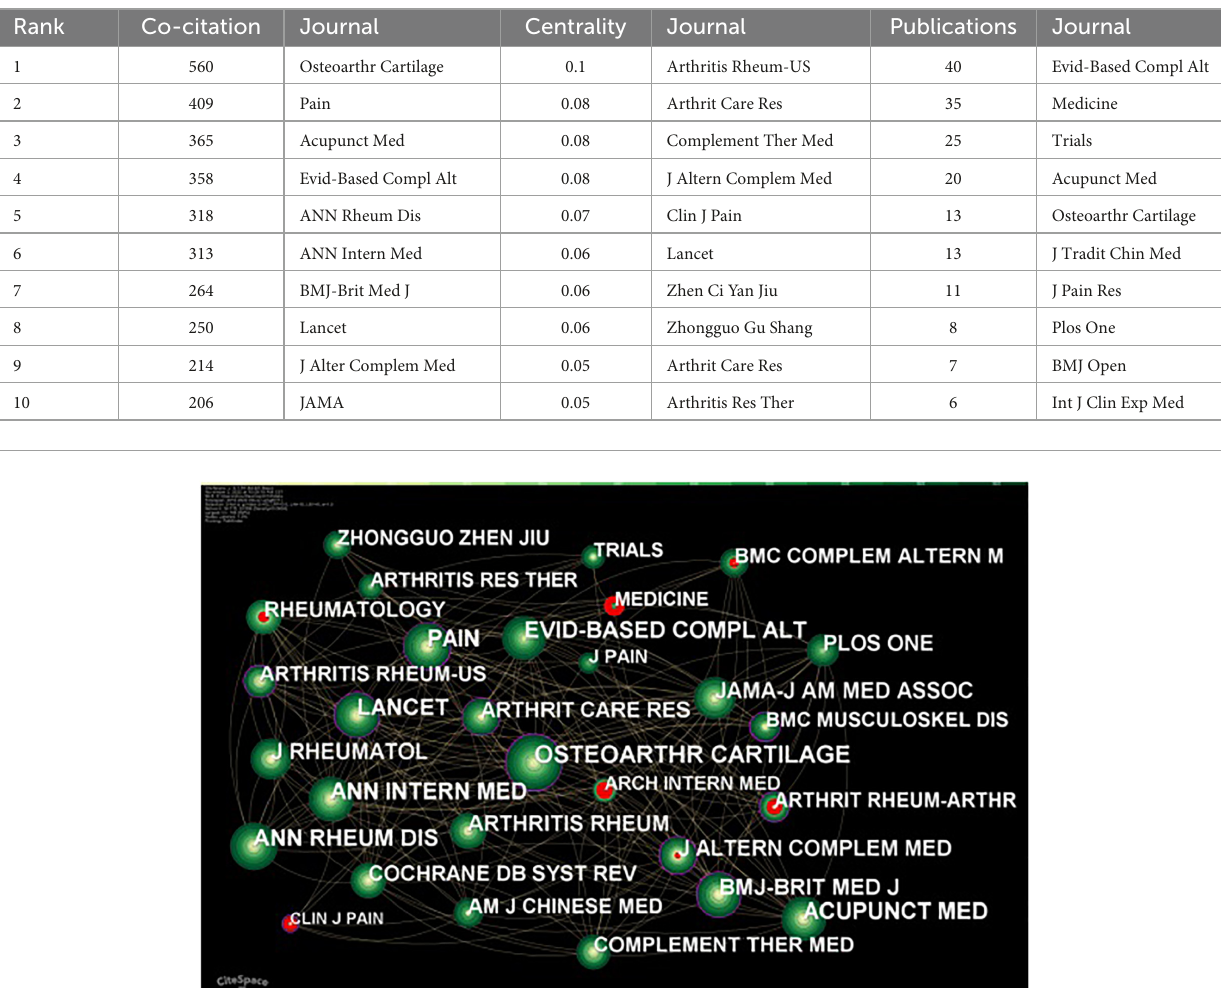
TABLE 6 Top 10 co-cited journals related to Chinese non-pharmacological therapy on KOA.